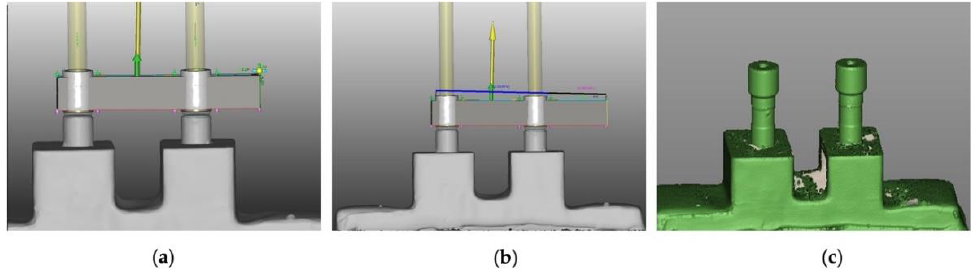
Figure 2. CAD/CAM elaboration of zirconia frameworks: ( a ) 6 mm cantilever; ( b ) 10 mm cantilever; ( c ) body scans.